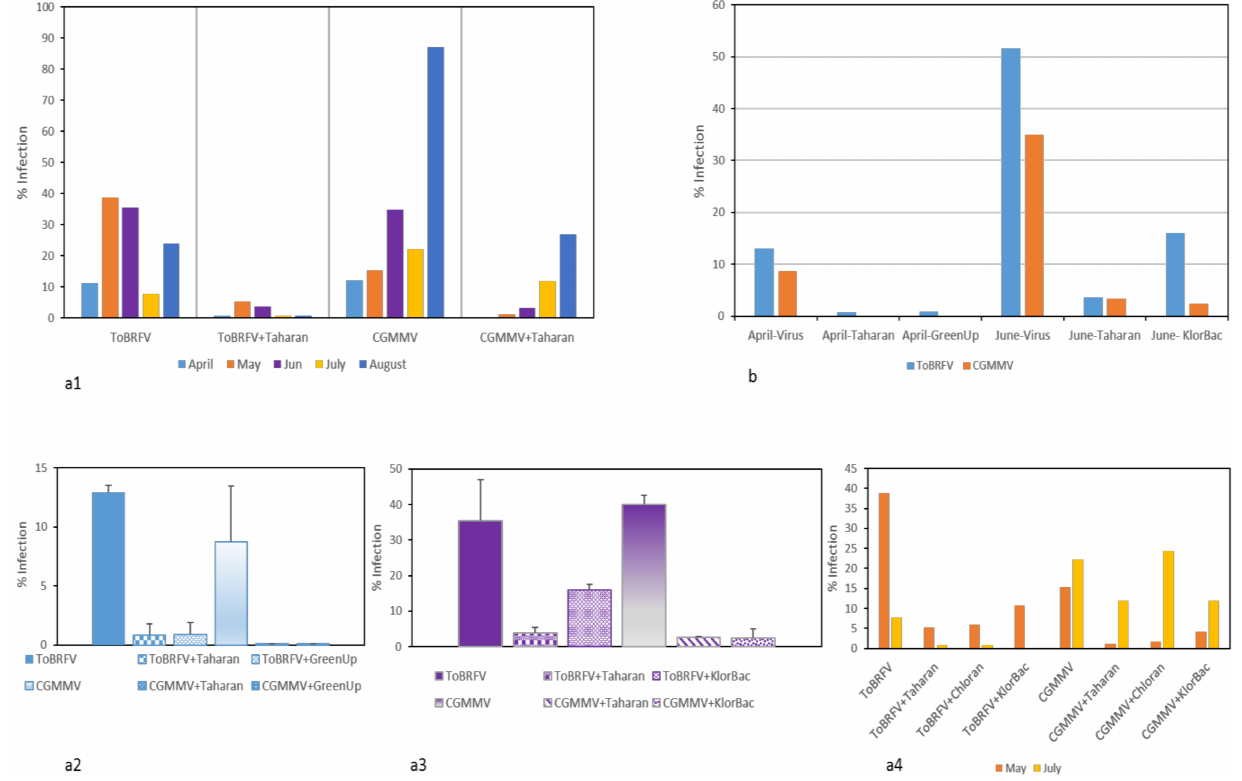
Figure 2. Disinfection efficacy in greenhouse studies during spring and hot summer in consecutive years, using an inoculum of either ToBRFV or CGMMV: ( a1 ) Taharan effect, studied between April and August, was significant for ToBRFV and CGMMV with p < 0.01 and p < 0.05, respectively, us- ing t -Test, paired with two samples for means. Number of plants was 90–250/treatment/month; ( a2 – a4 ) GreenUp ABV Chloran, and KlorBack were compared to Taharan (shown in ( a1 )) tested between April and June; ( a2 ) Taharan and GreenUP ABV disinfection efficacy were compared in April, n = 120–130/treatment; ( a3 ) a comparison between Taharan and KlorBack in June, n = 110–120/treatment; ( a4 ) a comparison between Taharan Chloran and KlorBack in May and July, n = 90–250/treatment; ( b ) a comparison between Taharan, GreenUp ABV and KlorBack in April and June in a subsequent year, n = 100–150/treatment. KlorBack disinfection efficacy tested on ToBRFV or CGMMV was significant with p < 0.016 and p < 0.024, respectively, using t -Test,